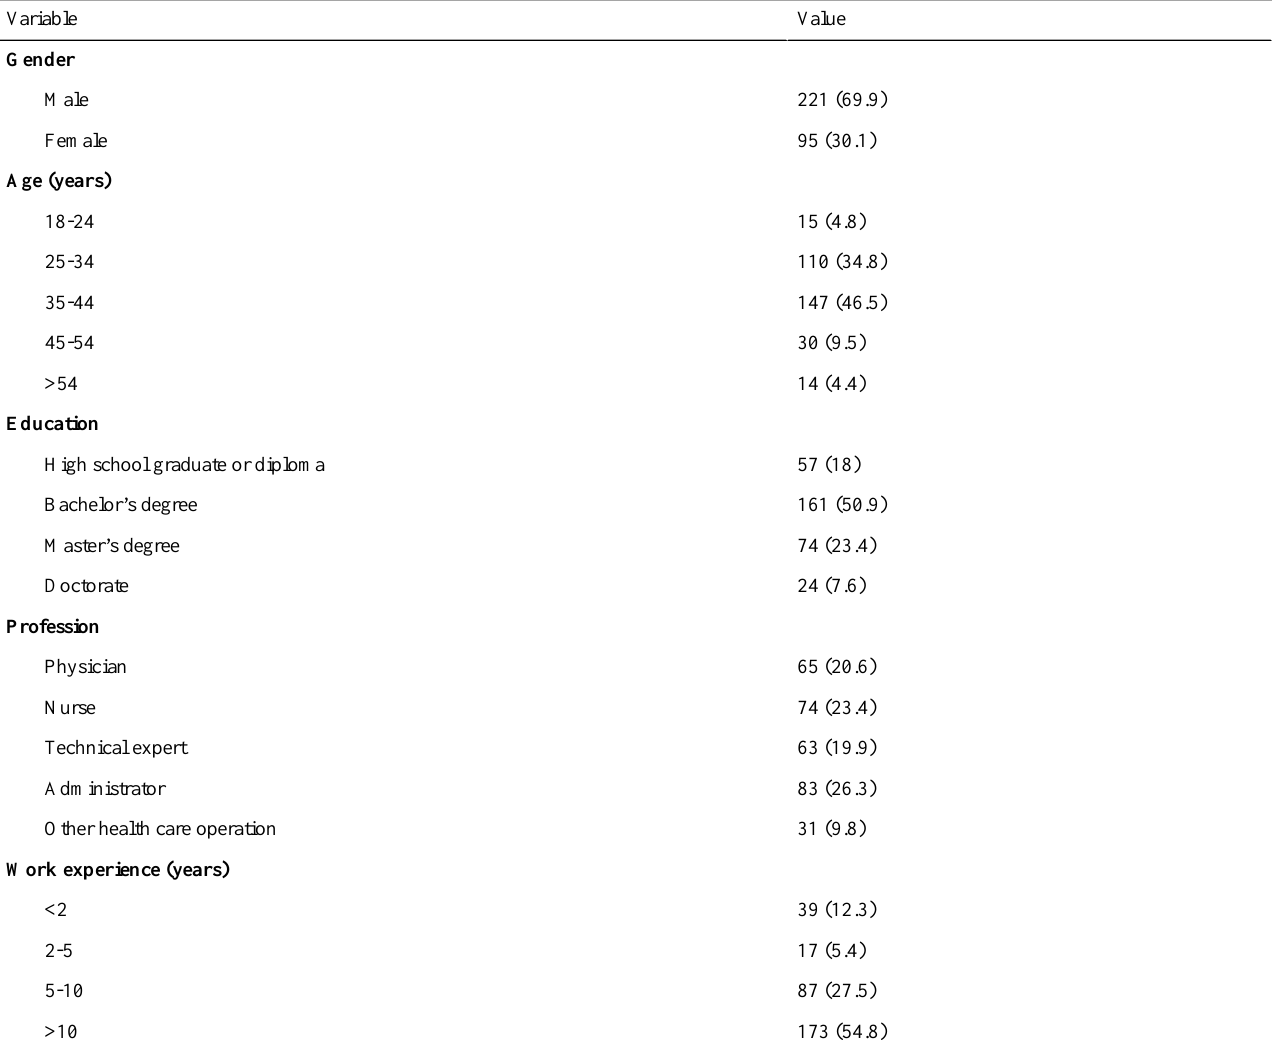
Table 1. Frequency distributions of key variables (N=316), n